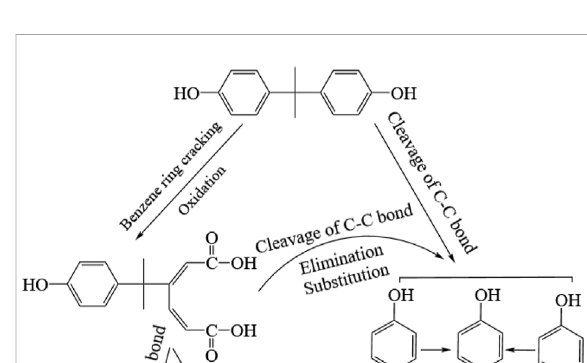
FIGURE 5 Values of Δ H and Δ G for the reactions between BPA and radicals by DFT calculation.